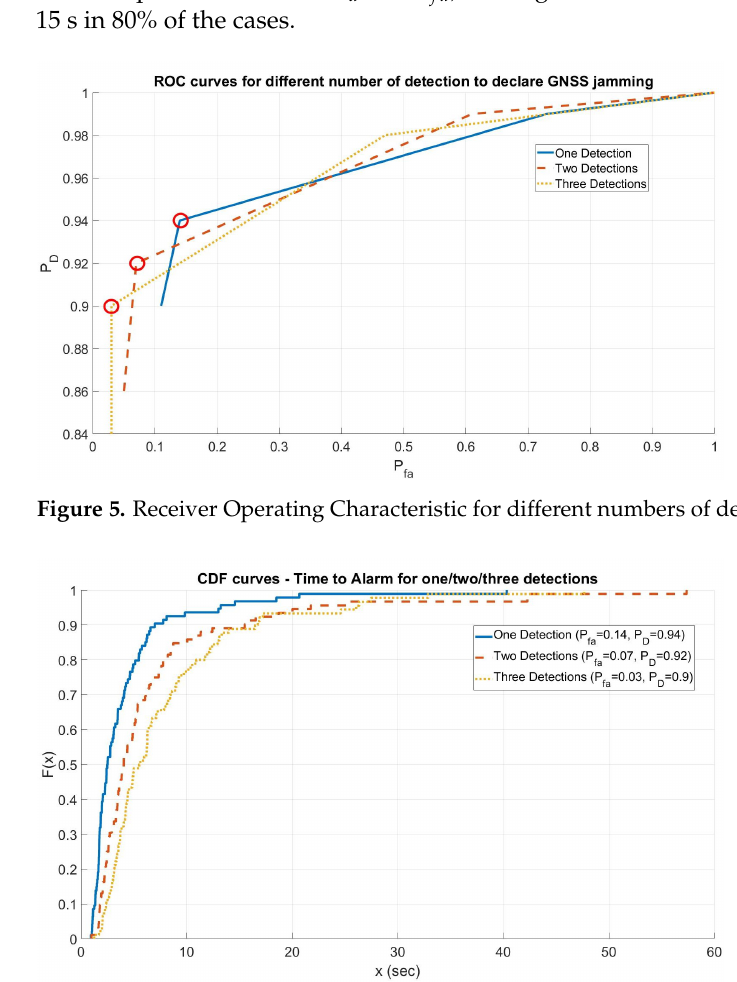
Figure 6. Cumulative Distribution Function for the Time to Alarm in the three different